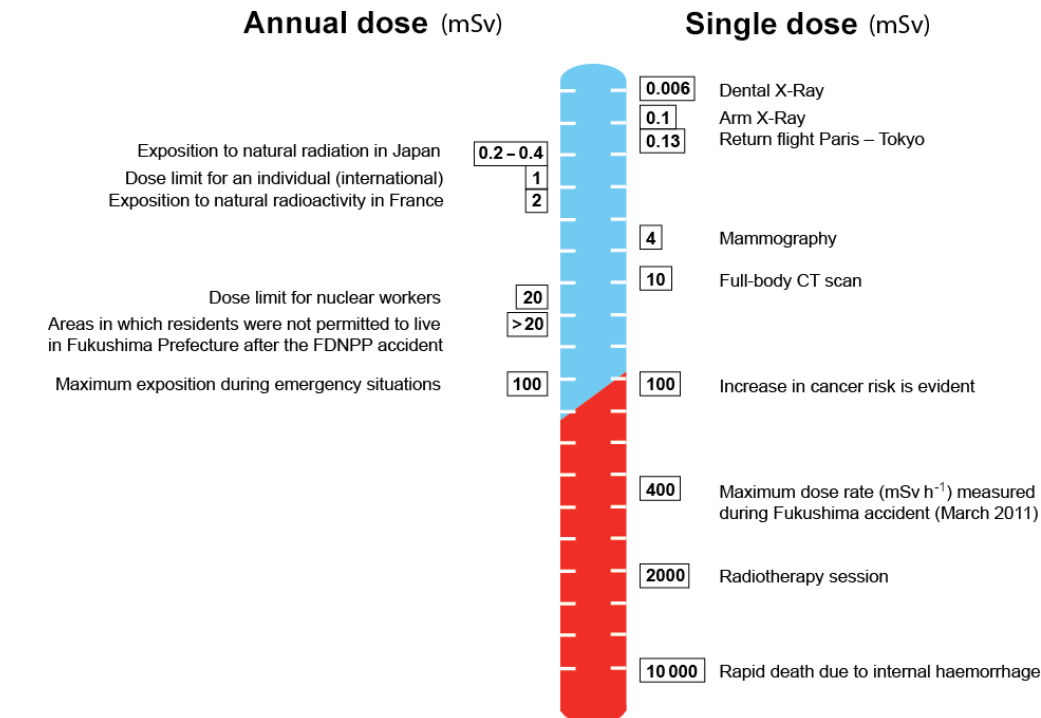
Figure 5. Comparison of annual and individual radioactive dose rates to which the population may be exposed, based on a compilation of data (Commissariat à l’Energie Atomique et aux Energies Alternatives, 2016; Harada et al.,